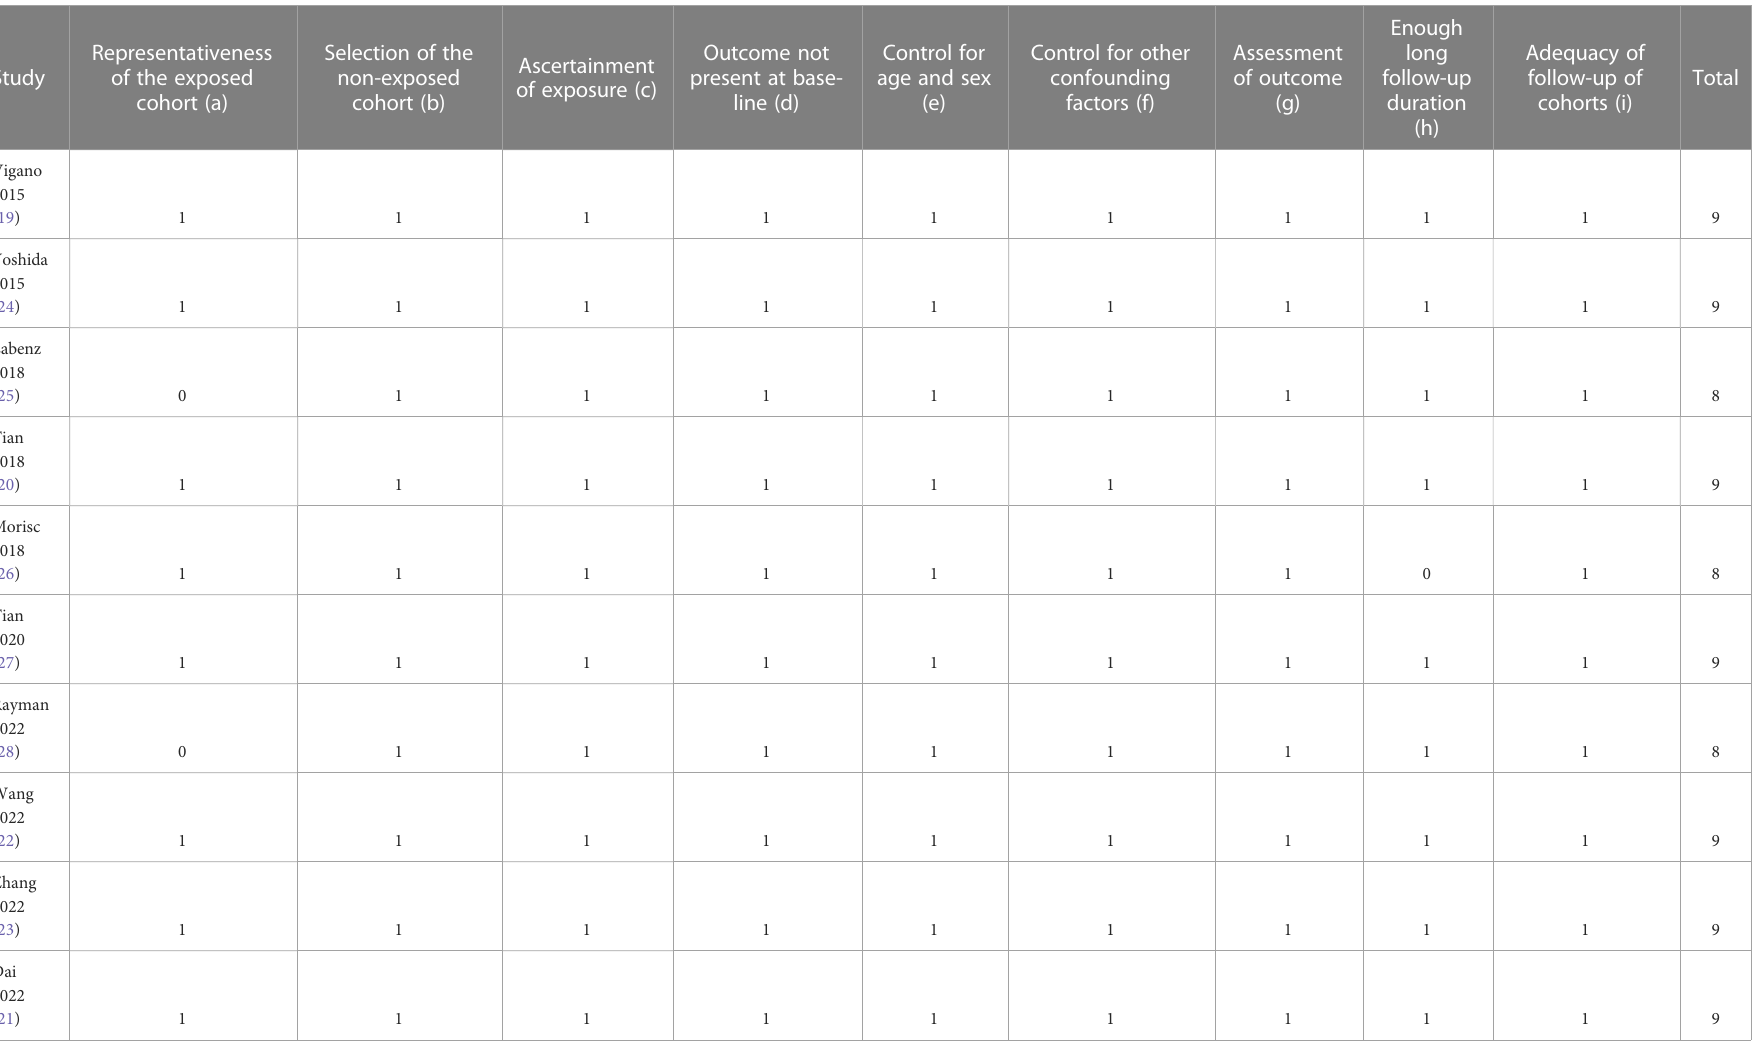
TABLE 2 Study quality evaluation via the Newcastle-Ottawa Scale.